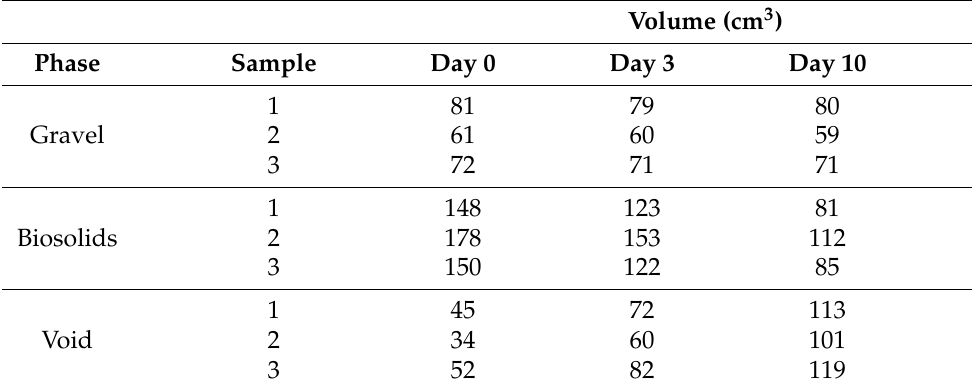
Table 2. Volumes of various phases over the entire